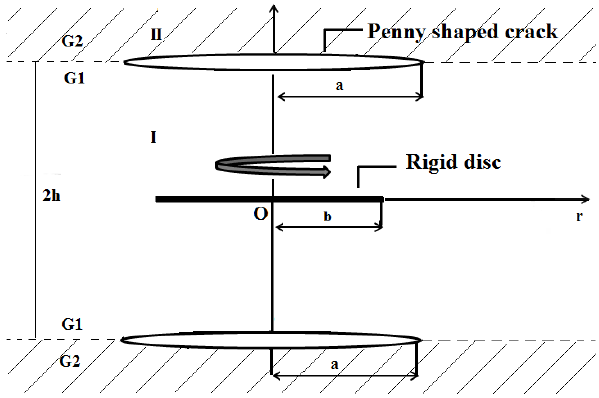
Figure 1: Geometry and coordinate